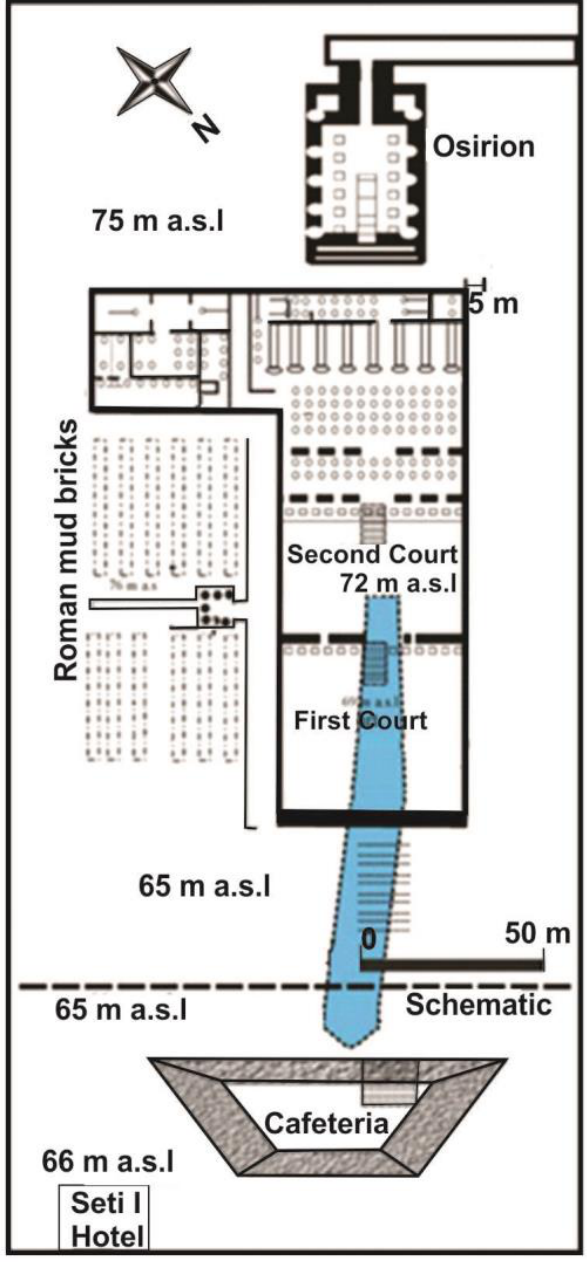
Figure 3. The identified subsurface discontinuities under Abydos Temple, modified [52]. Figure 4 provides a full translation of the Osirion’s ancient scenes and inscriptions, which claim that the king built a channel to transport the boats of the Abydene gods